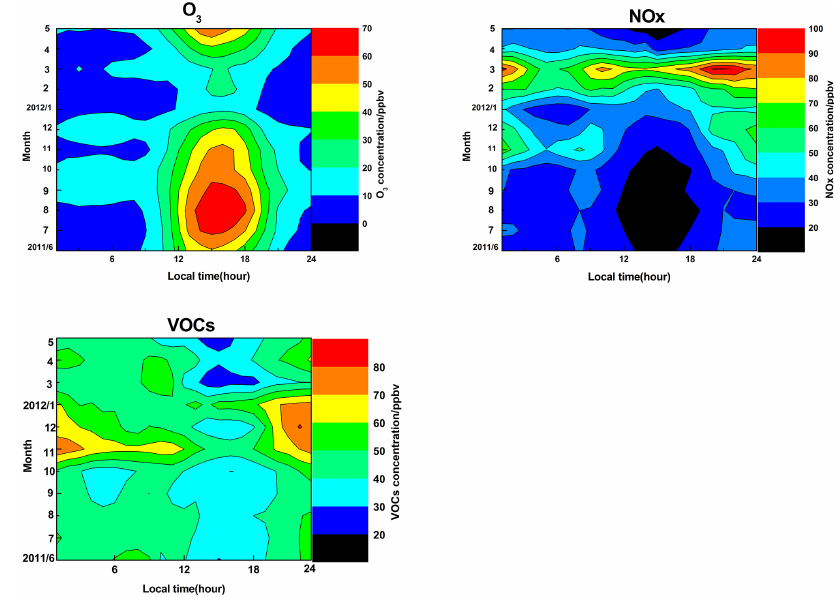
Figure 4. The seasonal-diurnal variations with daily 1h averages of ozone, NO x and VOCs from June 2011 to May 2012 at GPACS. Table 3. Daily average of VOCs categories, NO x and ozone in each season (from June 2011 to May 2012) at GPACS. Alkanes Alkenes Aromatics VOCs NO x O 3 (ppbv) (ppbv) (ppbv) (ppbv) (ppbv) (ppbv) Spring March 20.84 5.26 8.50 34.60 April 25.11 May Summer June